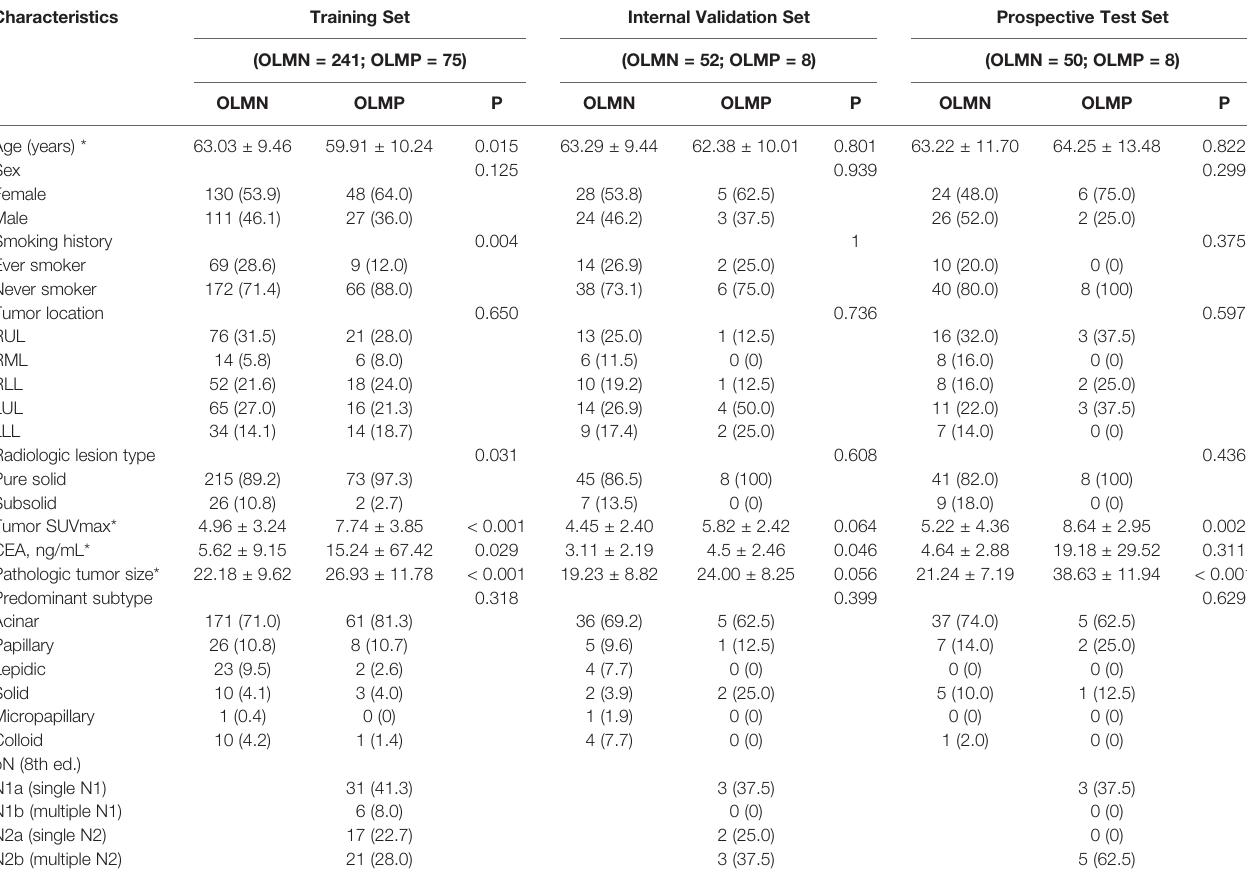
TABLE 2 | Comparison of clinical features between OLMN and OLMP groups in the three sets. Characteristics